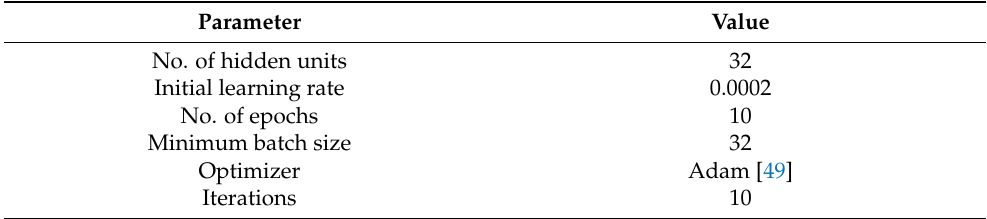
Table 3. Simulation